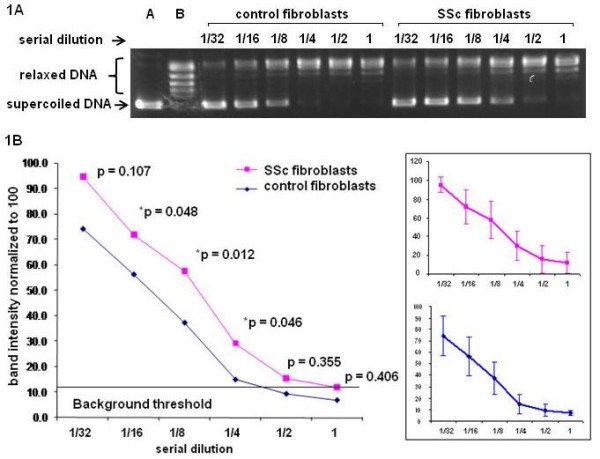
Measurement of catalytic function of topo I in cultured fibroblasts. A serial dilution of topo I in the nuclear extracts obtained from SSc and control fibroblasts was used to relax 0.25 μg supercoiled DNA. A. The supercoiled DNA band is gradually diminished following increased amounts of topo I in the nuclear extracts in the relaxing assays. The efficiency of SSc topo I in relaxing the supercoiled DNA appeared to be less than that of control topo I in each concentration of nuclear extracts. B. Comparison of 11 paired SSc and control fibroblasts for mean values of intensity of supercoiled DNA bands after relaxing assay with different concentrations of topo I in the nuclear extracts. Each P-value of comparison at different dilution points is listed in the figure. Comparison of average band intensity of remaining supercoiled DNA in each of six dilutions between all SSc and all control fibroblasts showed a significant P-value (P = 0.0041) (Student's t-test). A = standard supercoiled DNA band; B = standard relaxed DNA bands; the numbers (1/32, 1/16, 1/8, 1/4, 1/2 and 1) indicate serial dilutions of topo I in nuclear extracts used for relaxing supercoiled DNA. The error bars indicate standard deviation (SD).